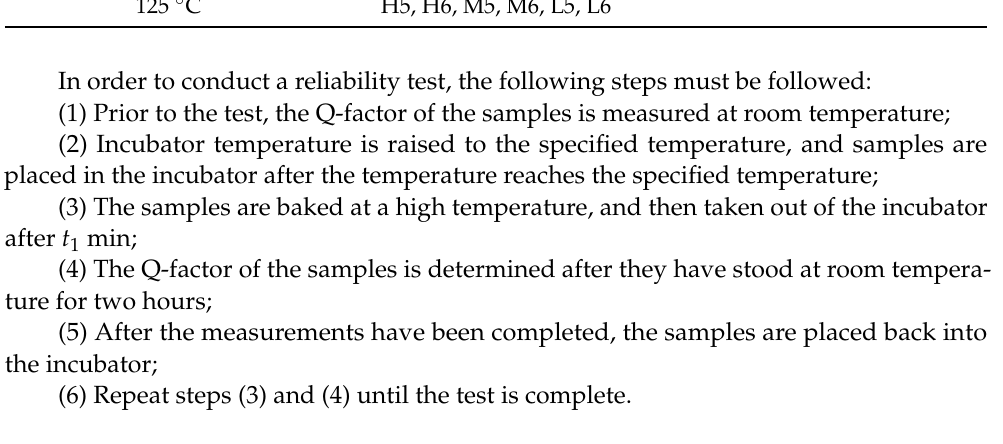
Figure 3. Degradation of Q-factor of vacuum packaged gyroscope with time at high temperature.